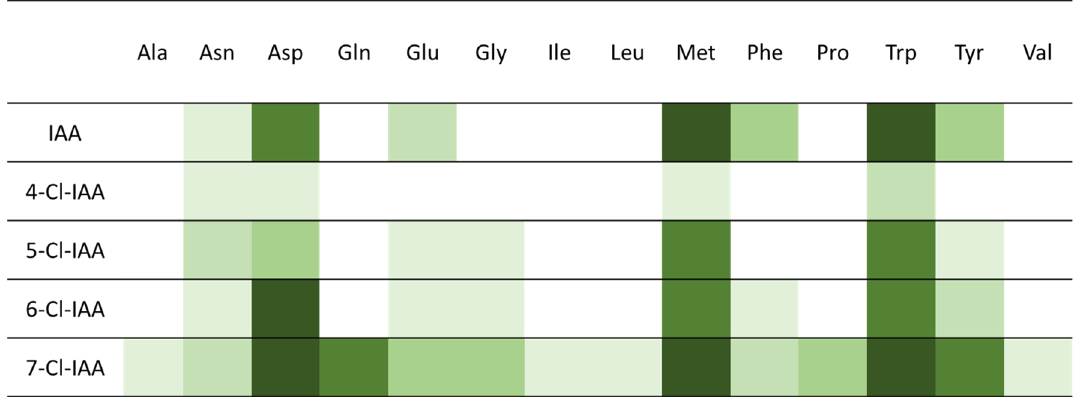
Figure 3. In vitro production of chlorinated IAA amino acid conjugates. Shown are the different produced chlorinated IAA conjugates with AtGH3.3 and different chlorinated IAAs as substrates in an in vitro experiment. Darker green colors = conjugates which are produced in higher amounts; lighter green colors = lower amounts are produced (based on the intensity of the spots of the thin layer chromatography (TLC) plates, Figure S2, and IAA estimates are based on [31]). Ala = alanine, Asn = asparagine, Asp, aspartate, Gln = glutamine, Glu = glutamate, Gly = glycine, Ile = isoleucine, Leu = leucine, Met = methionine, Phe = phenylalanine, Pro = proline, Trp = tryptophan, Tyr = tyrosine, Val = valine.